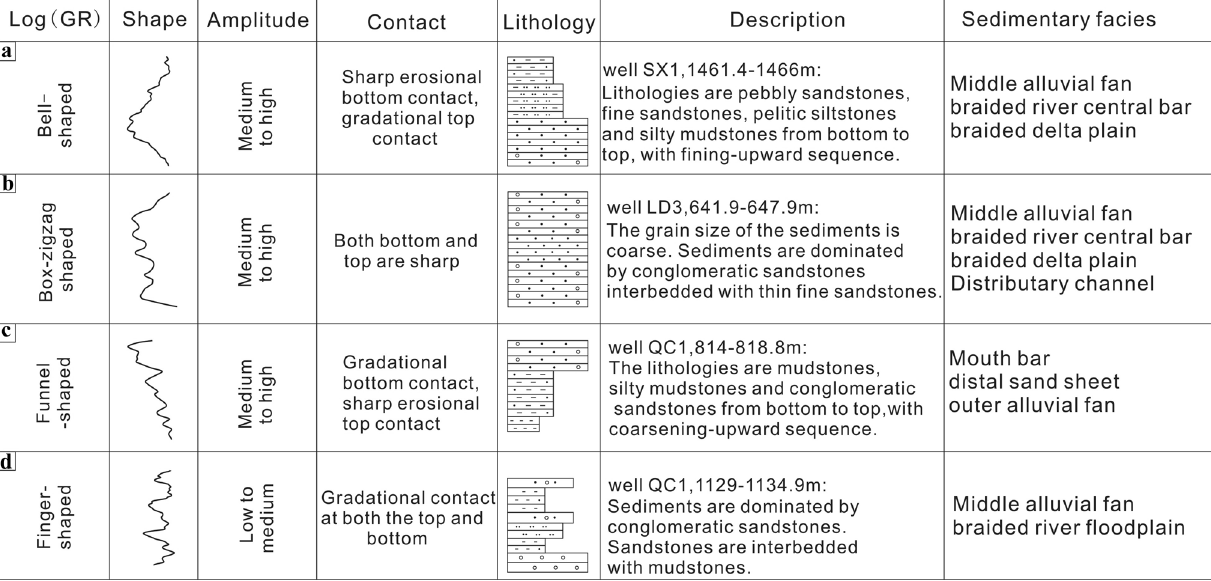
sedimentary facies of a Bell-shaped log. b Box-zigzag shaped log. c Funnel-shaped log. d Finger-shaped